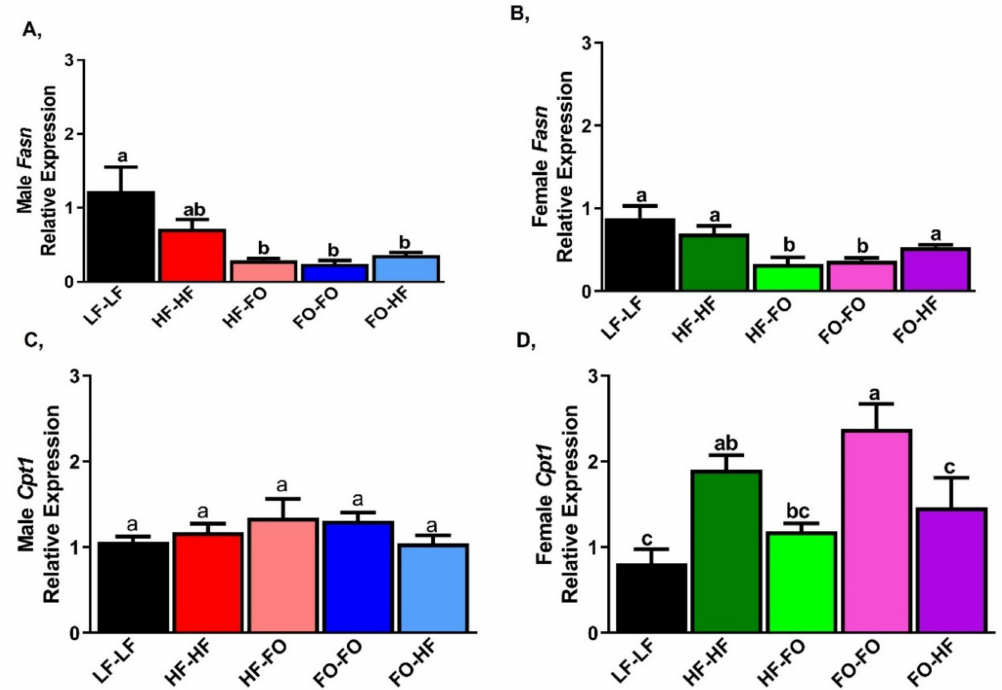
Figure 9. Fish oil alters markers of lipid metabolism in liver of males and females. ( A , B ) mRNA levels of fatty acid synthase ( Fasn ) in liver of males and female mice. ( C , D ) mRNA levels of carnityl palmitoyl transferase-2 ( Cpt2 ) in liver of male and female mice. Data is presented as mean ± SEM (n = 8). Common letters on the error bars indicate no significance (e.g., “a” is significantly different from “b” and “ab” indicates no significance compared to “a” and “b”). Male offspring groups had comparable mRNA levels of beta oxidation marker, Cpt1